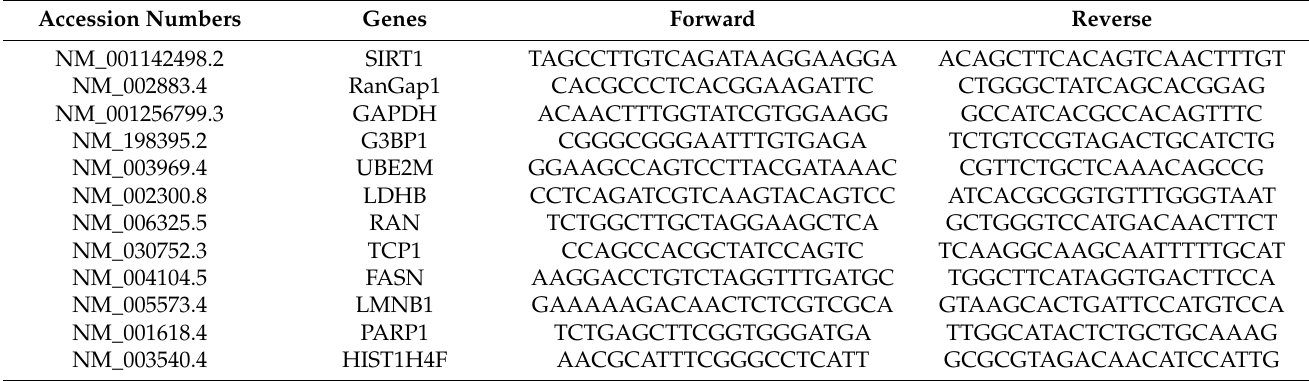
Table 1. Primers used for